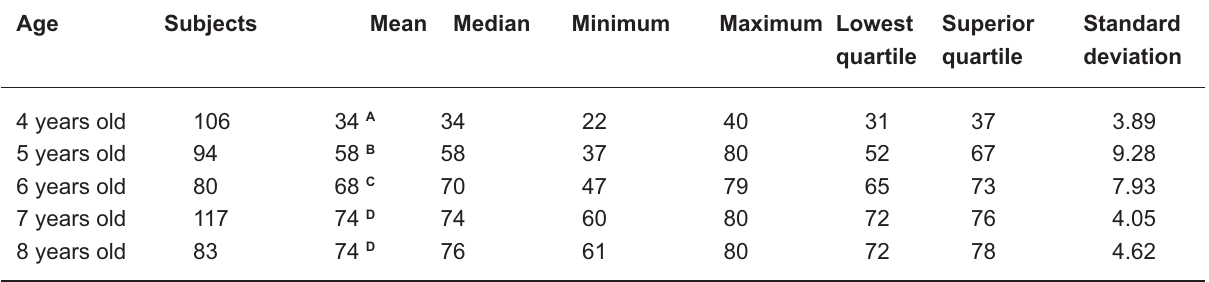
* Ages with the same letter in the mean are not statistically different.